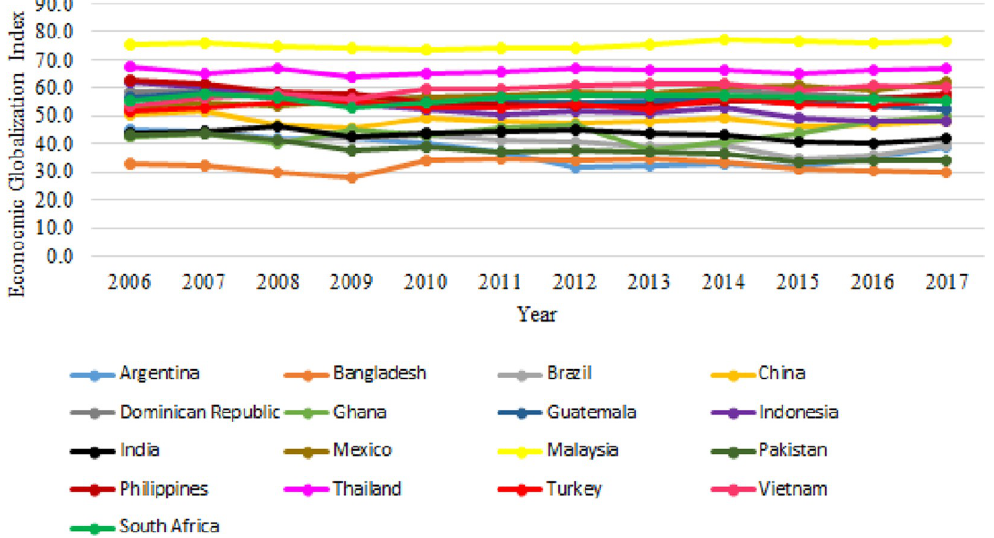
Fig 1. The index of the implementation of EG. Source: